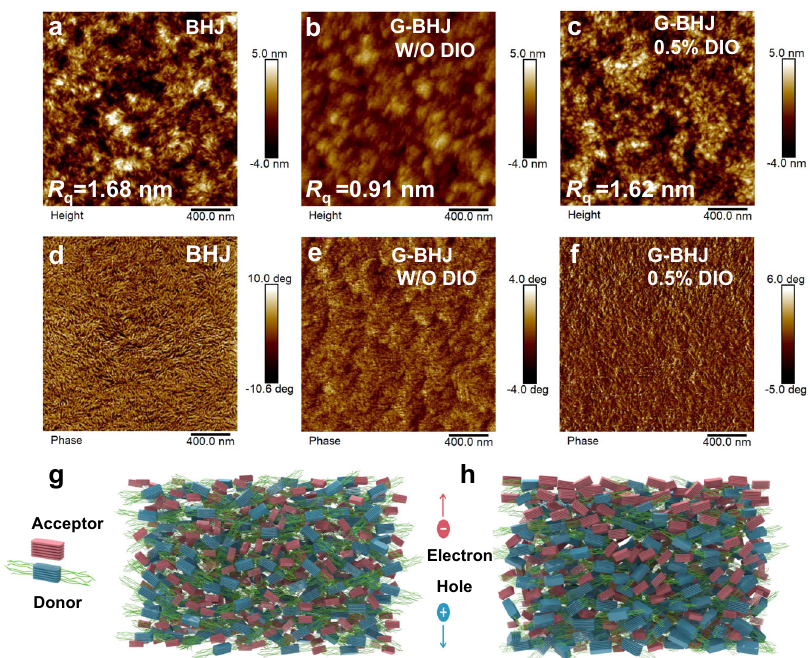
Fig. 4 The morphology of BHJ and G-BHJ fi lms. a – c AFM height images, d – f AFM phase images of the optimal BHJ fi lm, G-BHJ fi lm without DIO and the optimal G-BHJ fi lm with 0.5% DIO. The schematic morphology of g the optimal BHJ fi lm and h the optimal G-BHJ fi lm along the vertical direction.